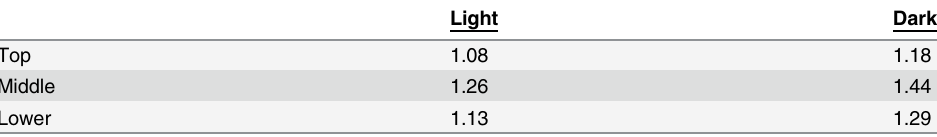
Table 1. Tetraploid:diploid hypocotyl cell-length ratios. Light Top Middle Lower 1.29 The ratios of cell-lengths between tetraploid and diploid in the top, middle and lower regions of hypocotyls derived from 5-day-old light- and dark-grown seedlings were calculated using the data shown in Fig 2.